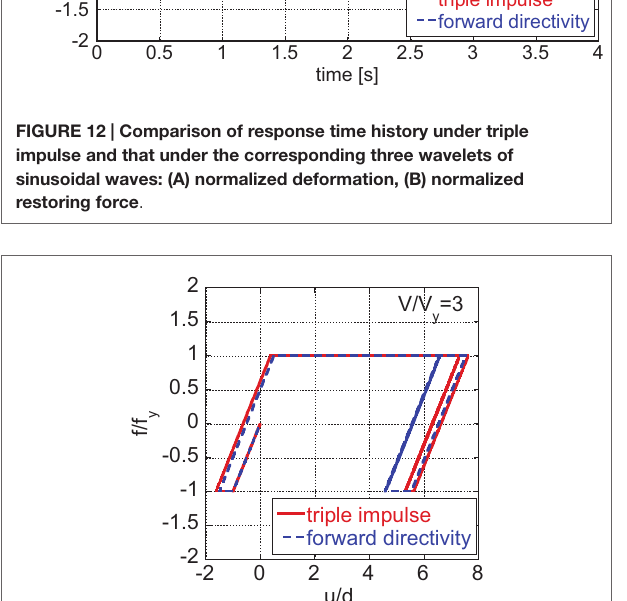
FigUre 12 | comparison of response time history under triple impulse and that under the corresponding three wavelets of sinusoidal waves: (a) normalized deformation, (B) normalized restoring force .